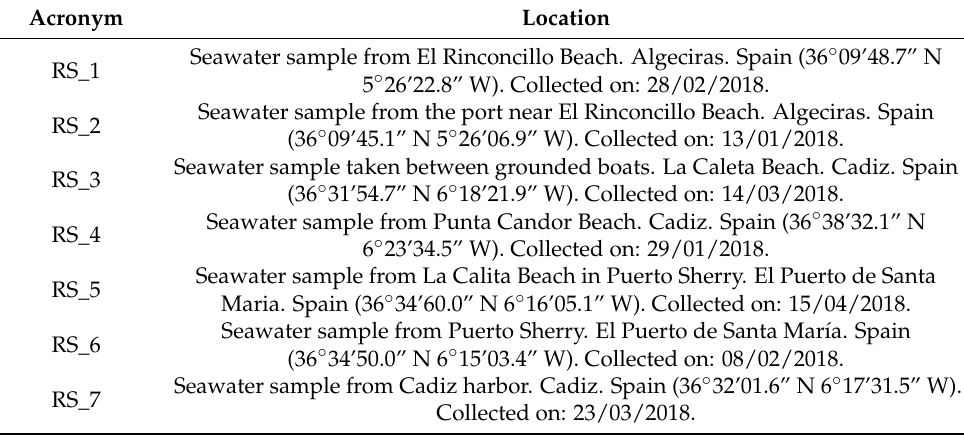
Table 1. Natural seawater samples collected to optimize the analytical method: location and identifi- cation acronym